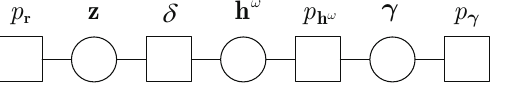
Figure 2. The factor graph of uplink sparse channel